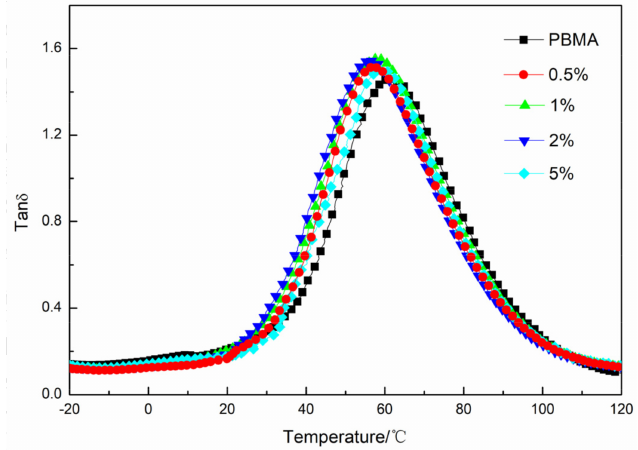
Figure 7. The temperature dependence of loss tangent (tan δ ) at 1 Hz for PBMA and